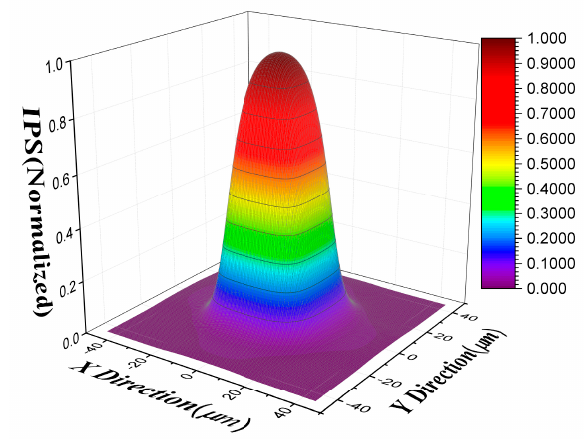
Figure 3. True IPS of the simulation.